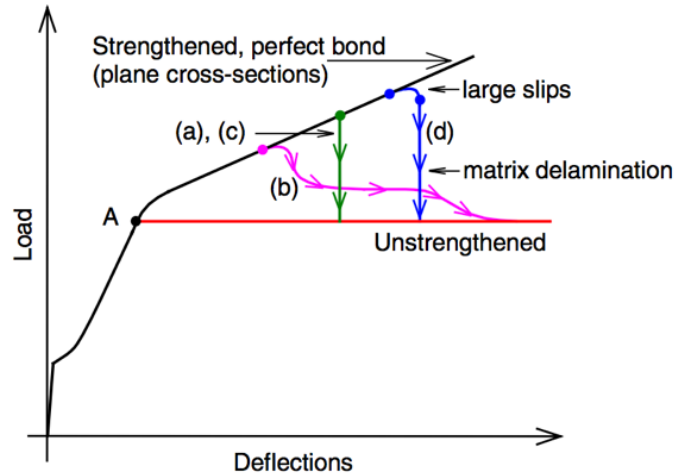
Figure 5. Typical load-deflection behavior and failure modes of RC beams strengthened in flexure using FRCM [4]. Reproduced with permission from [4]. Copyright, D’Ambrisi, A., 2014.